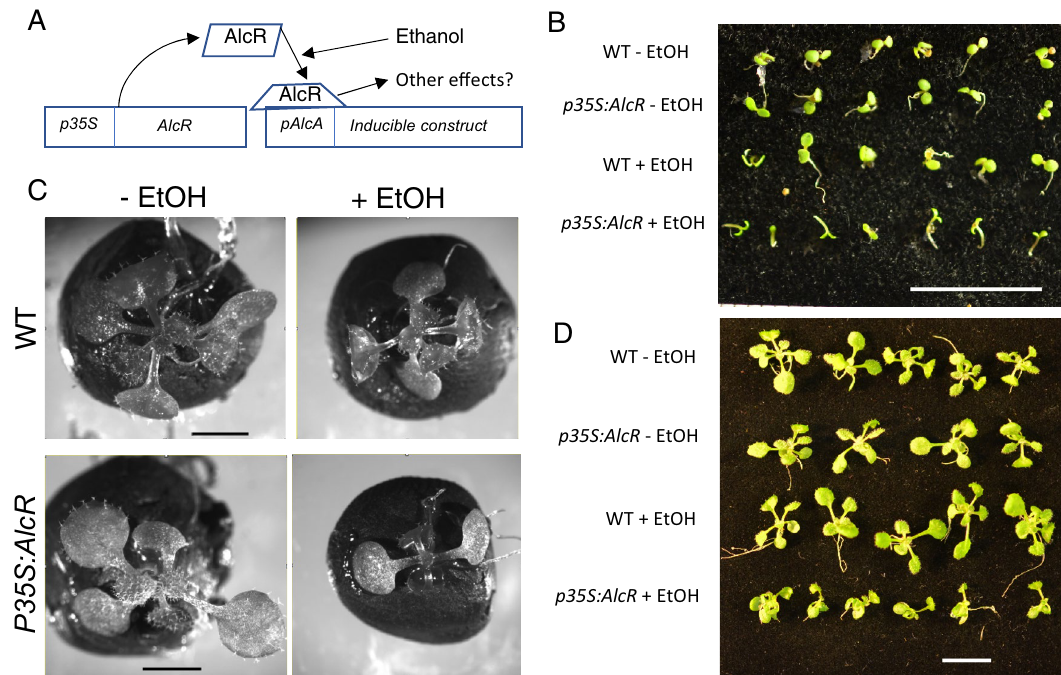
Figure 1. Post germination growth is retarded in p35S:AlcR seedlings. ( A ) Model of the supposed mechanism of action of the ethanol-inducible system in plants. ( B ) 3 DAS seedlings grown together in the presence of ethanol since stratification. Reduced growth can be seen in the bottom row. Scale bar = 10 mm. ( C ) Ethanol was added to a subset of seedlings at 3 DAS and images were taken at 7 DAS. Scale bar = 3 mm. ( D ) Ethanol was added at 6 DAS and images taken at 12 DAS. Again, growth is retarded in the p35S:AlcR seedlings when grown in the presence of ethanol. Scale bar = 10